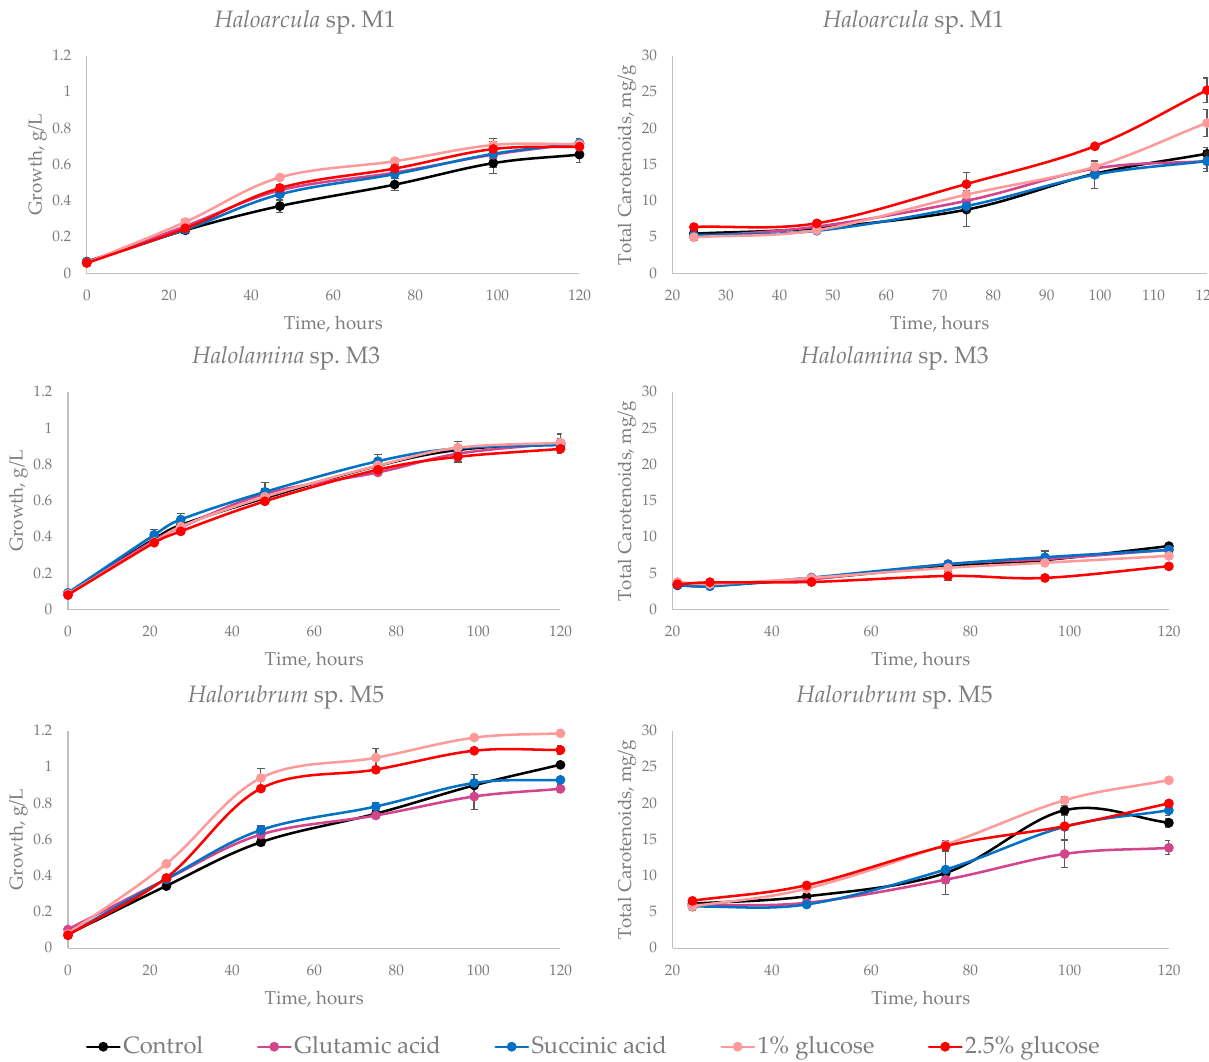
Figure 6. Effect of carbon source on growth and carotenoid production; the standard deviation at each point is shown.